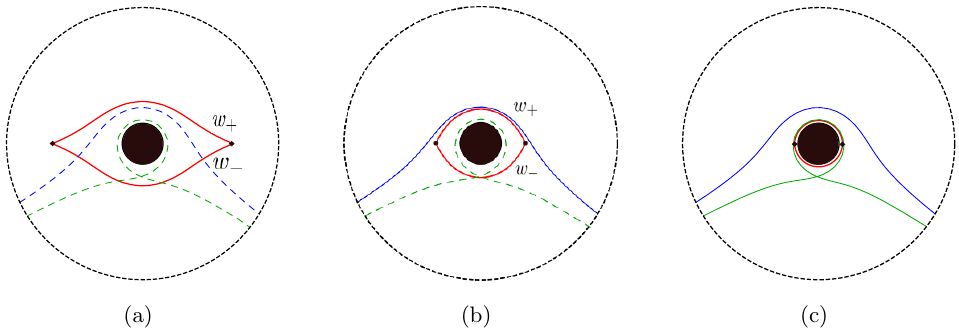
Figure 13 . Emergence of winding geodesics during the black hole creation. The blue geodesic has n = 1, and the green geodesic has n = (cid:0) 1. Here the disc depicts the bulk region r < 1, with the horizon at r = R = 0 :